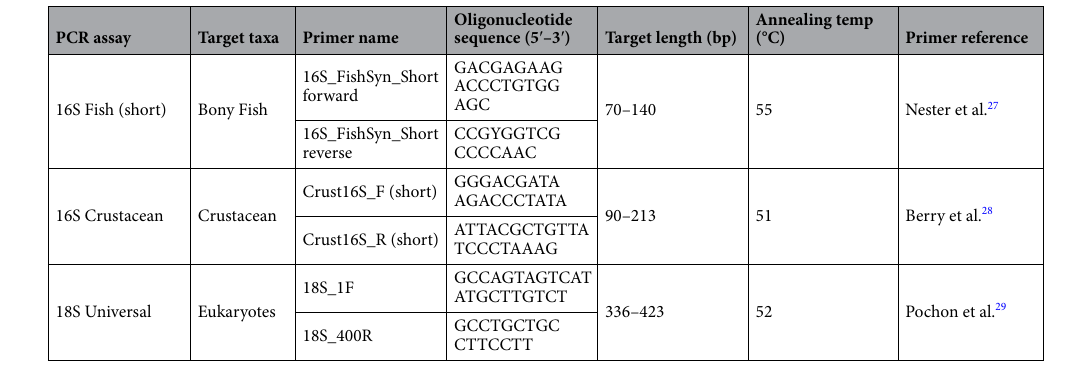
Table 2. Metabarcoding assay information for subterranean eDNA surveys on Christmas Island. Three PCR primer sets: 16S Fish (short), 16S Crustacean and 18S Universal corresponding to the mitochondrial 16S rRNA and nuclear 18S regions, were applied to all collected water and sediment samples. In the primer name, “F” refers to the forward primer and “R” to the reverse